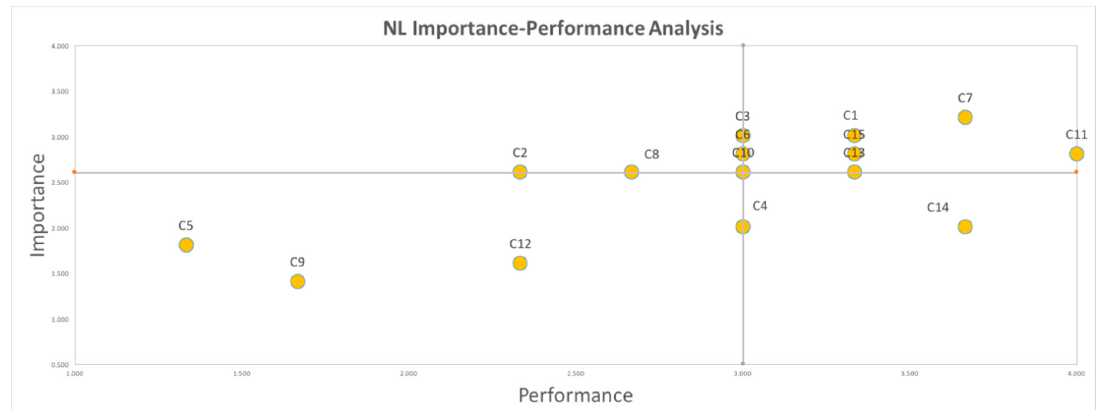
Figure 3. IPA chart based on data gathered in the Netherlands, 2019 (created by authors). where C1— IPA chart based on data gathered in The Netherlands, 2019 (created by Spotting Opportunities, C2—Creativity, C3—Vision, C4—Valuing Ideas, C5—Ethical and Sustainable